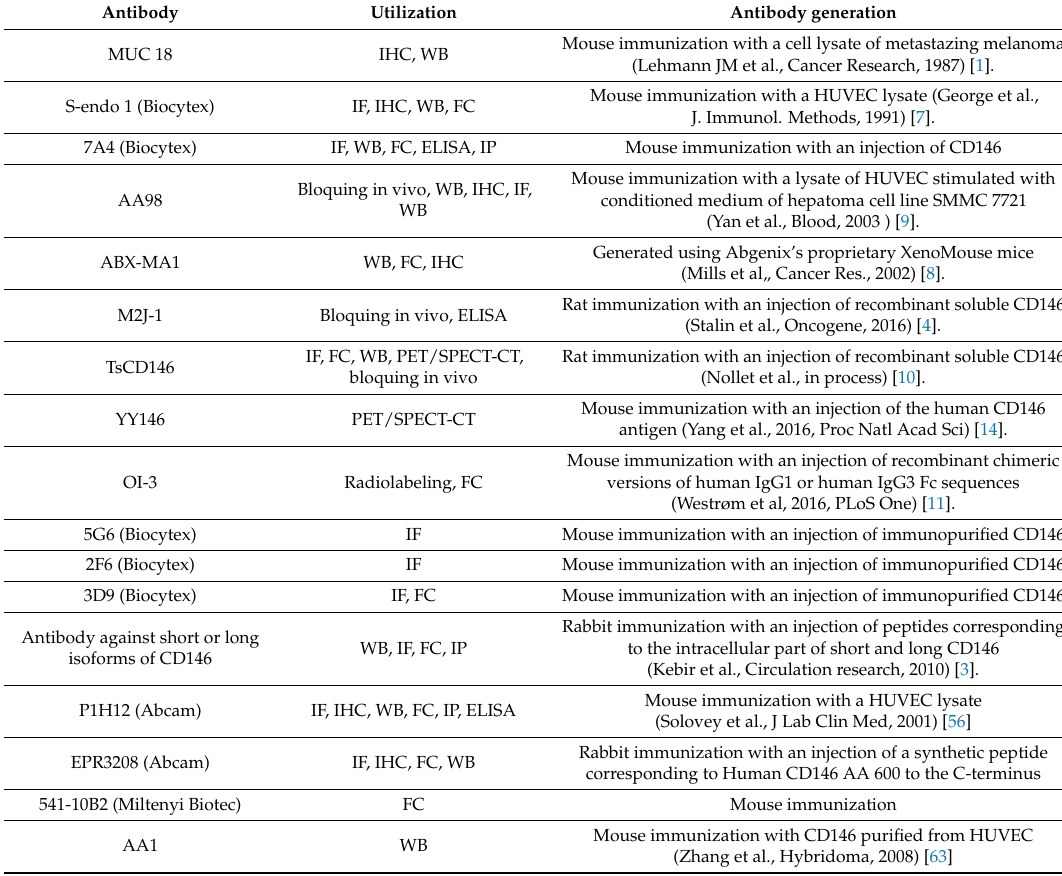
Table 1. Description of available anti-CD146